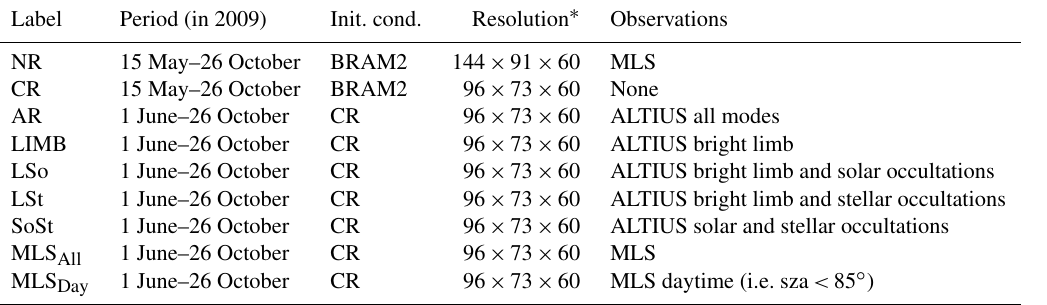
Table 2. List and configuration of BASCOE numerical experiments used in this study. Label Period (in 2009) Init.